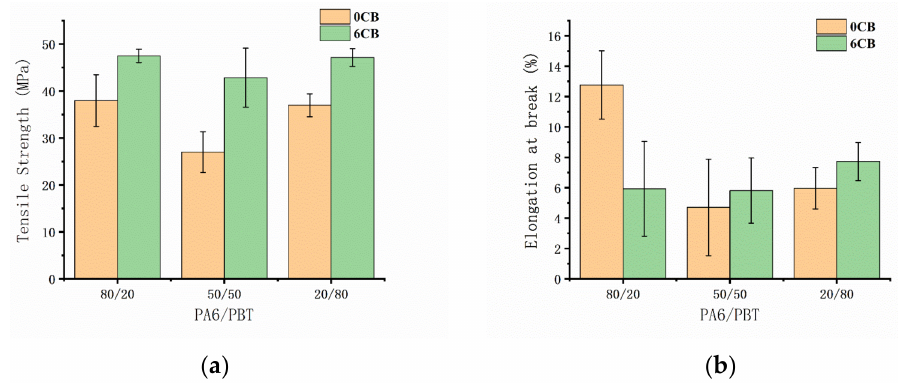
Figure 8. Tensile strengths ( a ) and elongations at break ( b ) of PA6/PBT-CB composites with CB contents of 0 and 6